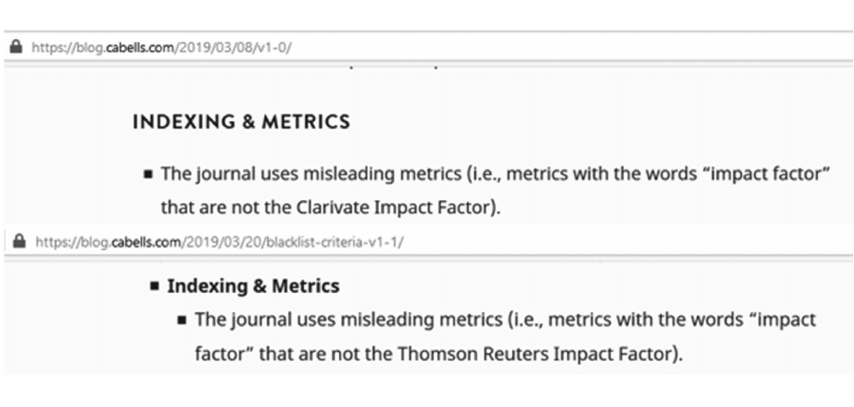
Fig. 9: Inconsistent updating of information relating to Cabell’s misleading metrics criterion, which indicates a discrepancy between their v1.0 (top) and v1.1 (bottom) criteria versions. Screenshots captured on February 20,